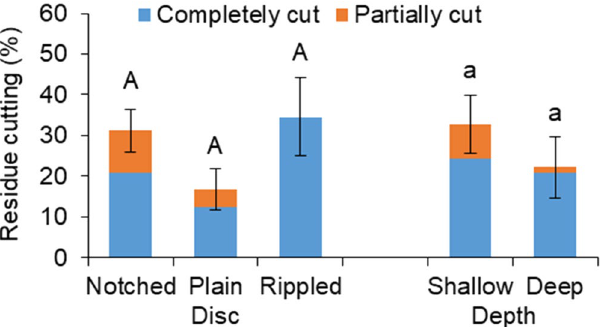
Figure 4. Residue cutting including completely cut and partially cut of different discs at different working depths; means followed by different lower case letters or upper case letters are significantly different according to Tukey’s test at the significance level of 0.05; error bars are standard